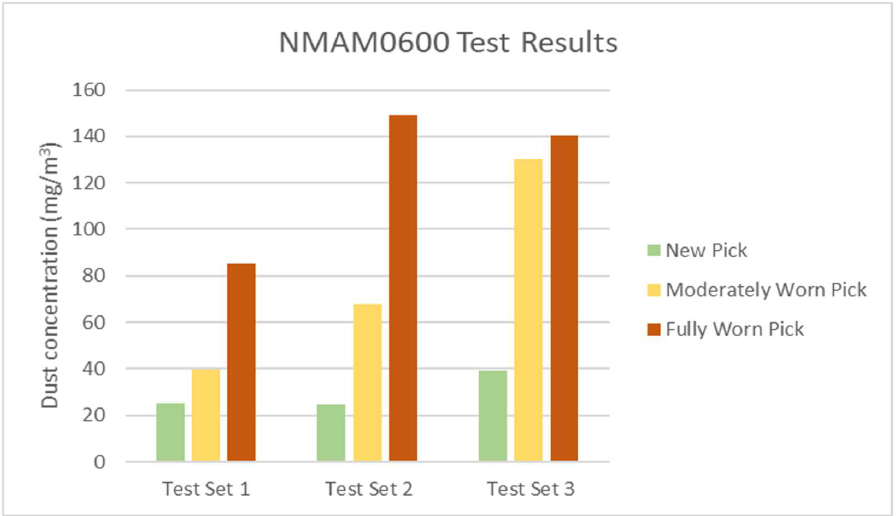
Figure 6. Concentration levels of suspended respirable limestone dust generated for each pick wear.